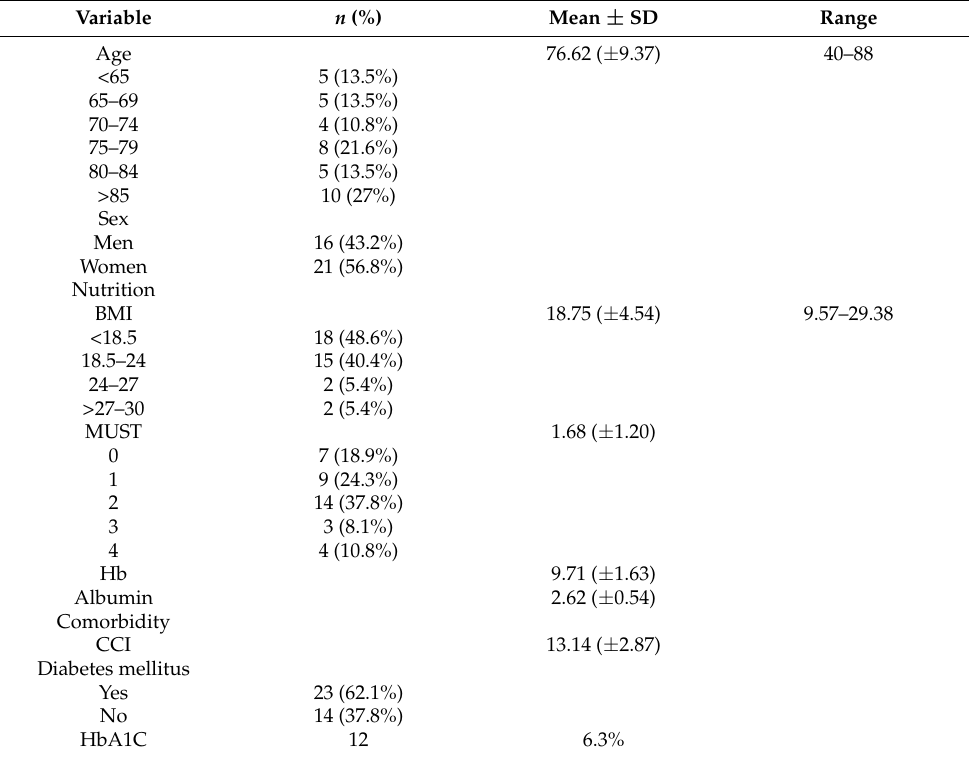
Table 1. Demographic data and clinical characteristics ( n =